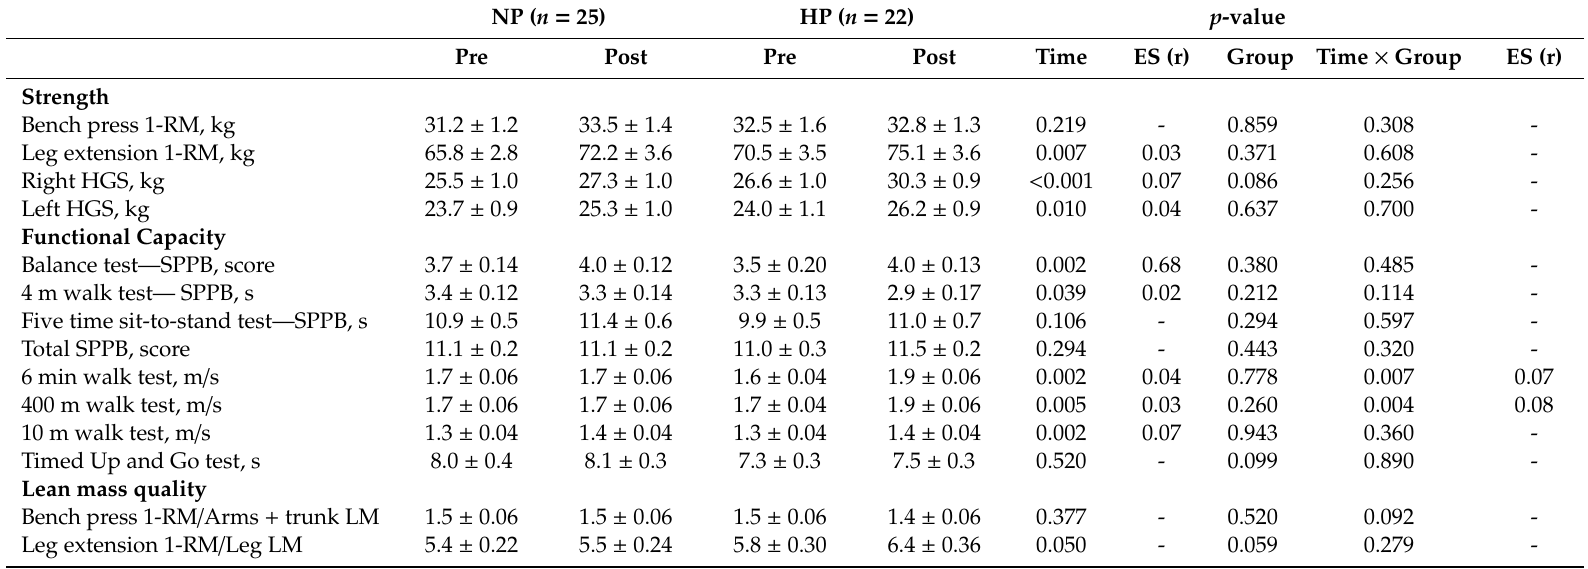
Table 3. Strength, functional capacity and lean mass quality values according to moments and groups, with multiple imputation